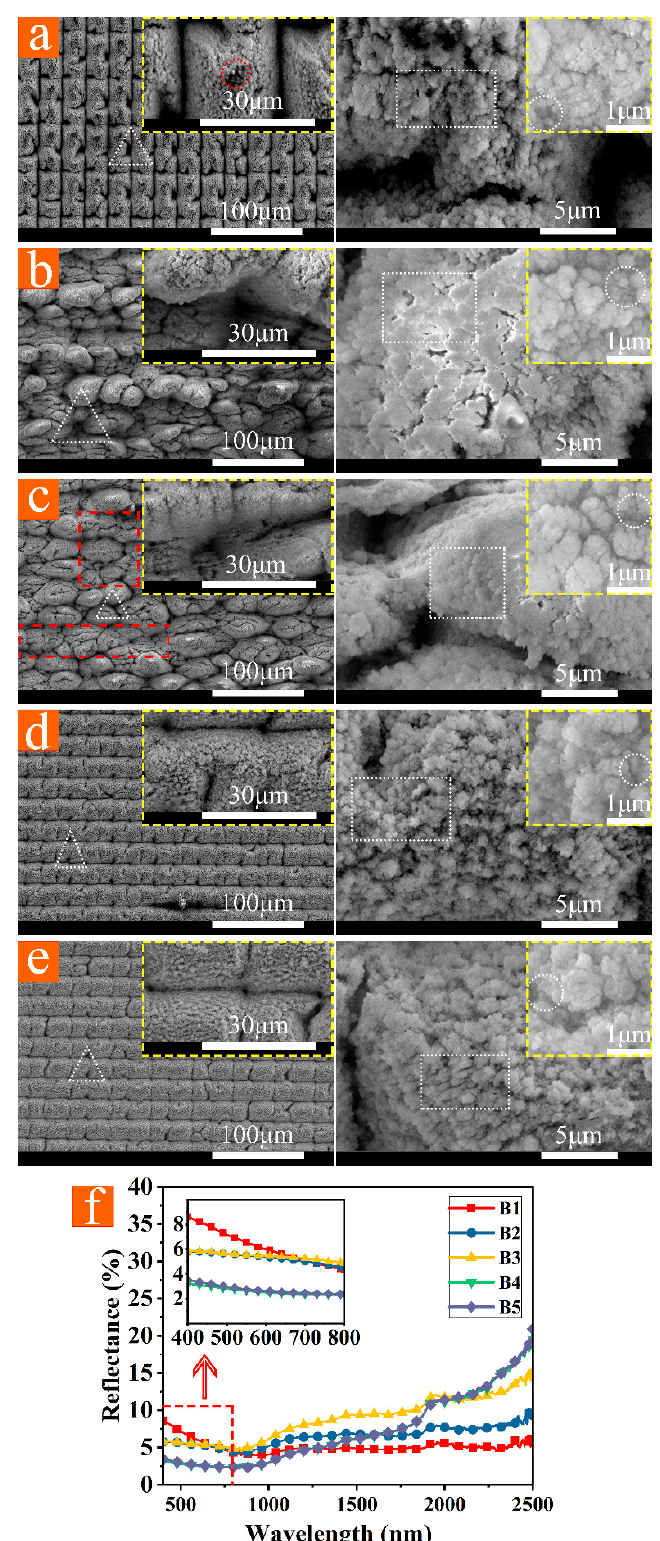
Figure 5. ( a – e ) SEM photographs (magnification of 1200 times, 5000 times, 20,000 times, and 100,000 times) of B1, B2, B3, B4, and B5. ( f ) Reflectance curves of B1–B5. Triangles (white), rectangles (white), and circles (white) represent, respectively, microscale light-trapping structures, subwavelength structures, and nanoparticles.